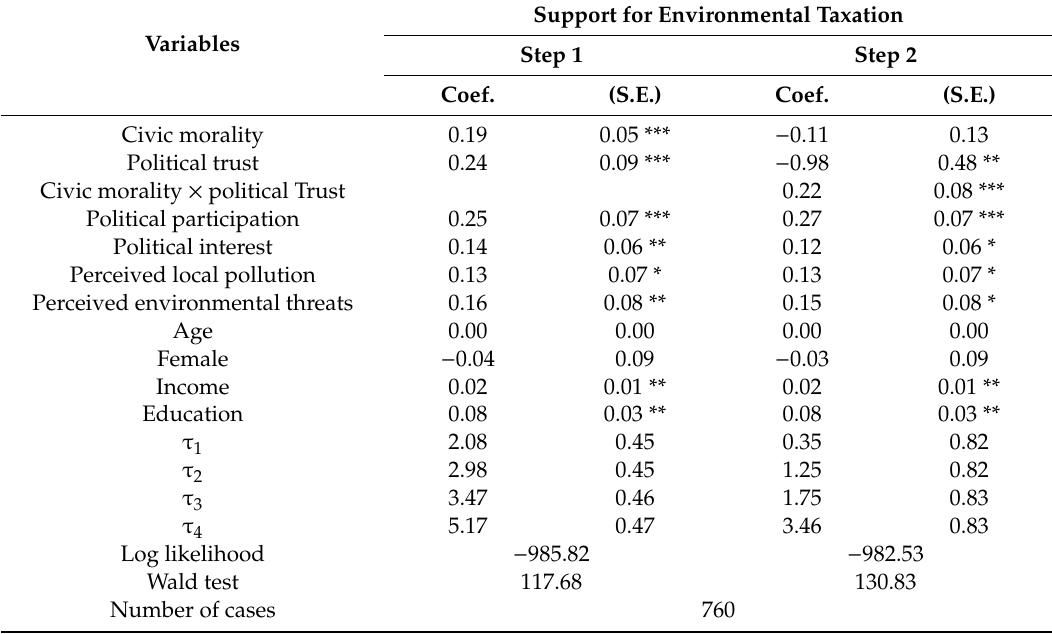
Table 2. Regression